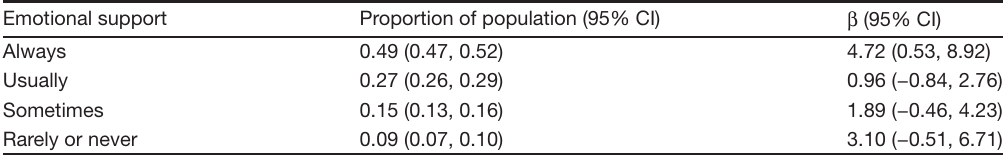
Table 4. Differences in anxiety ( β ) with direct contact with oil, by frequency of emotional support, in communities participating in the